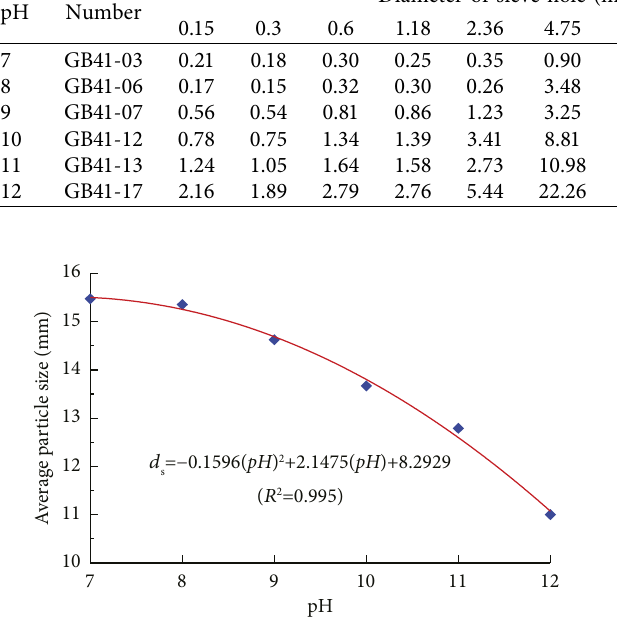
Figure 12: Variation of average particle size of sandstone speci- mens’ fractions with